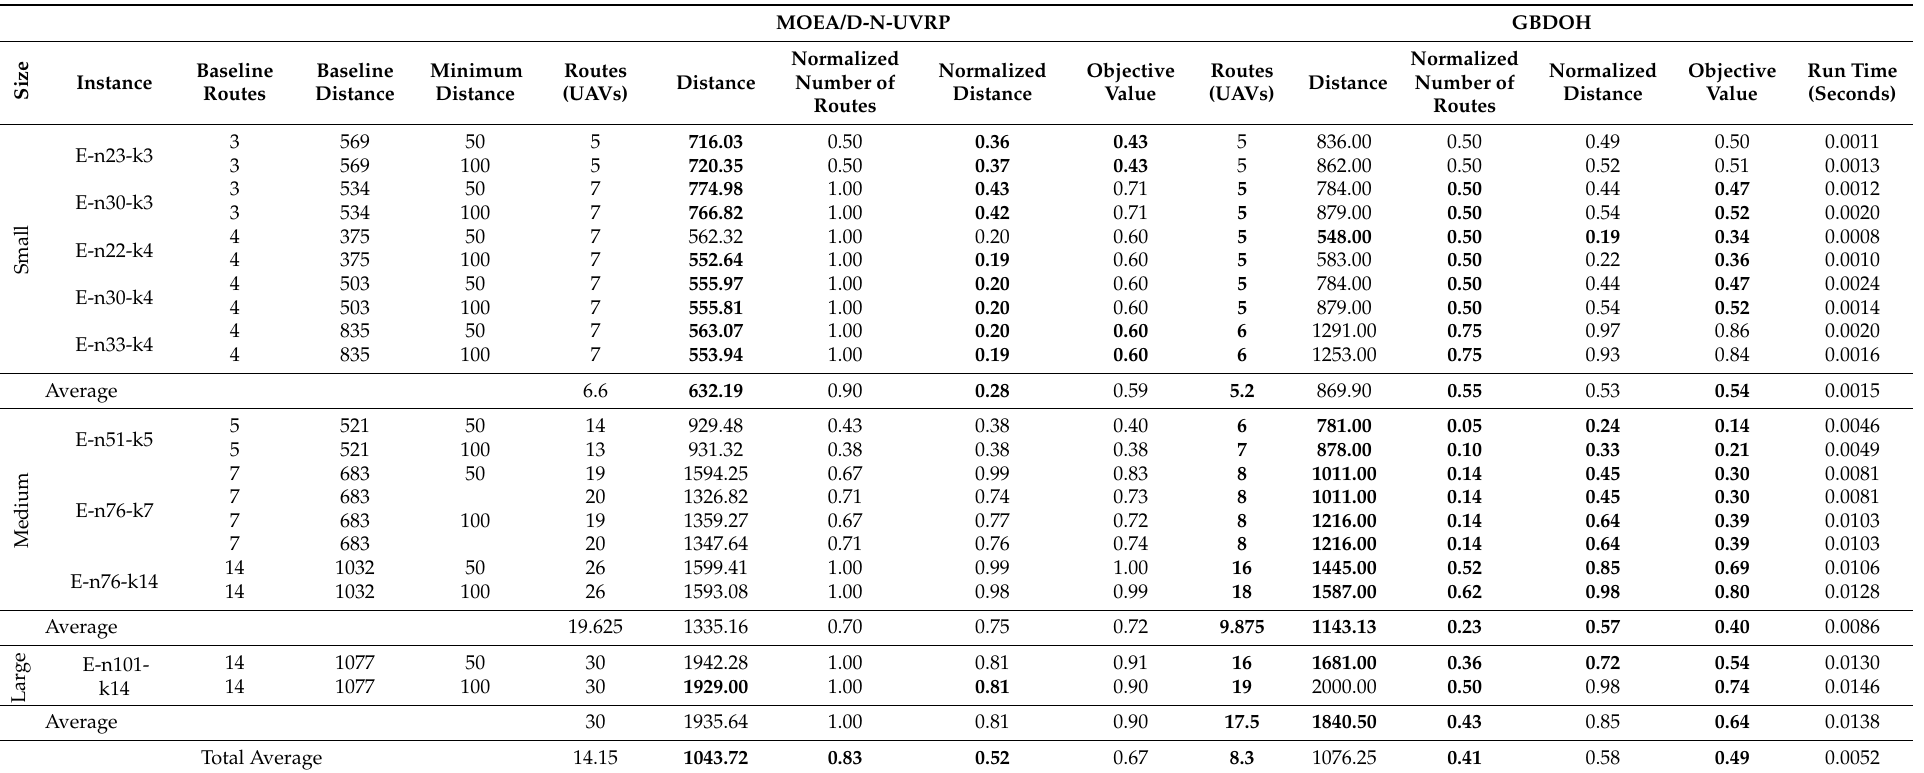
Table 3. Comparison between the MOEA/D-N-UVRP and GBDOH, the bold font indicates best values for each instance. MOEA/D-N-UVRP